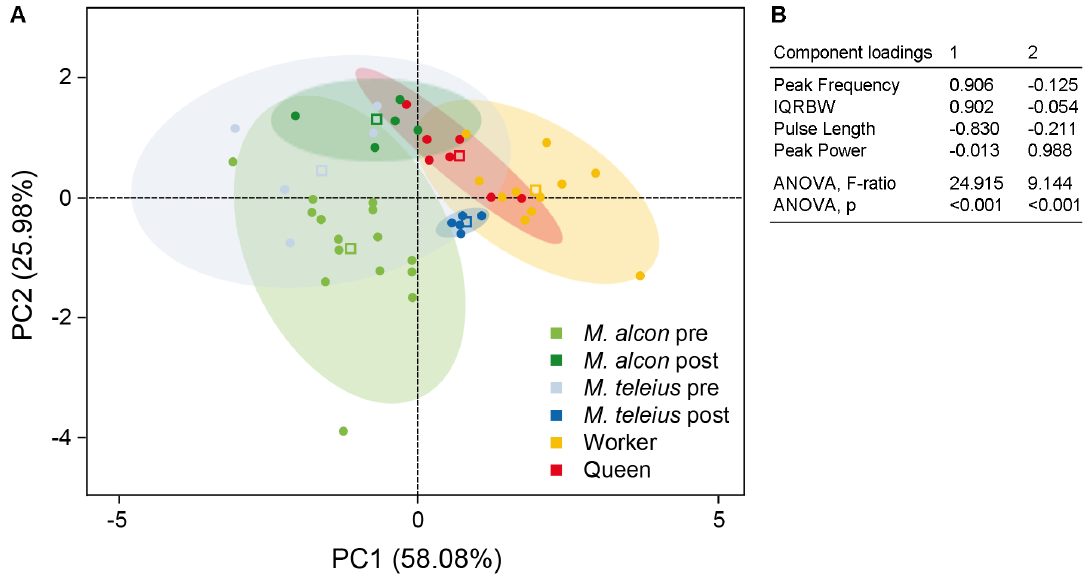
Figure 3. Principal Components Analysis (PCA) on the four sound parameters. (a) Two-dimensional plot of the first two factors extracted by principal components analysis over all individual measurements of the four sound parameters (peak frequency, peak power, IQRBW and pulse length) for each insect category - Myrmica scabrinodis queens and workers and Maculinea alcon and M. teleius pre- and post-adoption caterpillars. Ellipses indicate 95% confidence intervals; squares show the centroids for each category. (b) The component loadings extracted by PCA from the four sound parameters are reported in the table. ANOVA based on the 6 groups of samples are also reported.